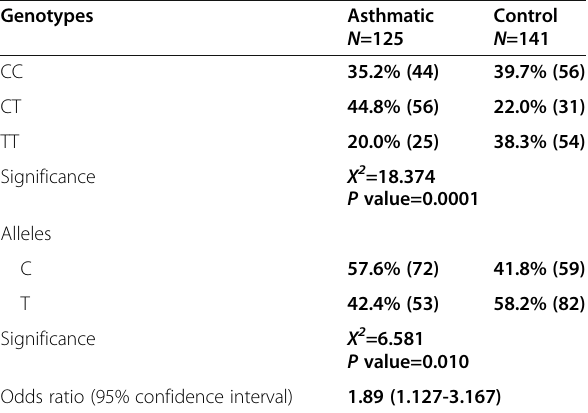
Table 5 The distribution of rs10192157 ( IL1RL1 gene) polymorphism genotype and allele frequencies in the